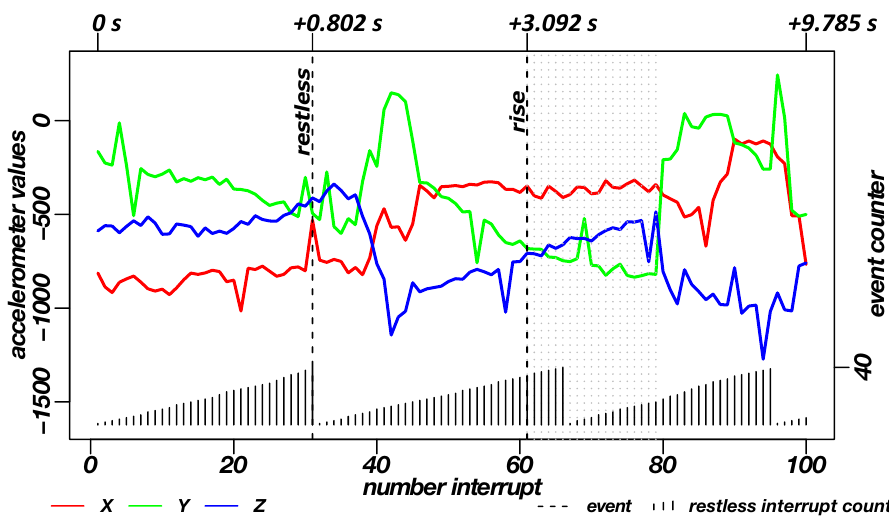
Figure 14. Diagram of the recorded data of the INBED wearables during a rising measurement on the subject. By means of the red-green-blue graphs, the recorded raw triaxial acceleration data of the sensor node can be seen for each interrupt of the wearable. Plotted in the lower area is the restlessness counter state, which counts up to the threshold of 40. A dashed line shows the triggering of the alarms (restlessness and uprising) in the diagram. For the rise event after the triggered alarm grey dotted lines are plotted to represent the standing. In the upper part the time interval of different milestones to the first interrupt is marked.